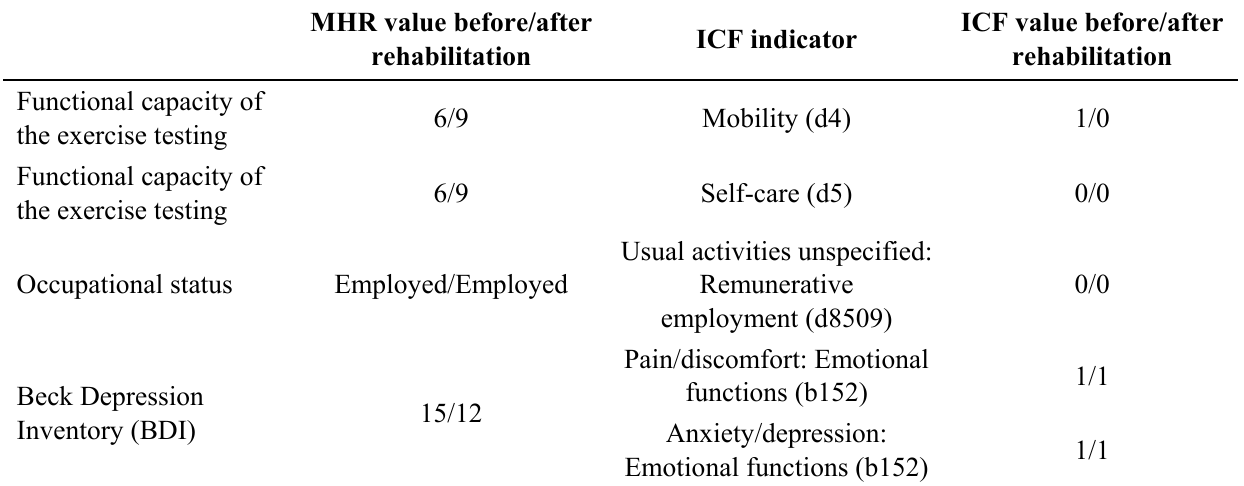
Table 2. Albert’s case: 50-year-old man who participates in a motor rehabilitation process (walking) during 115 days.